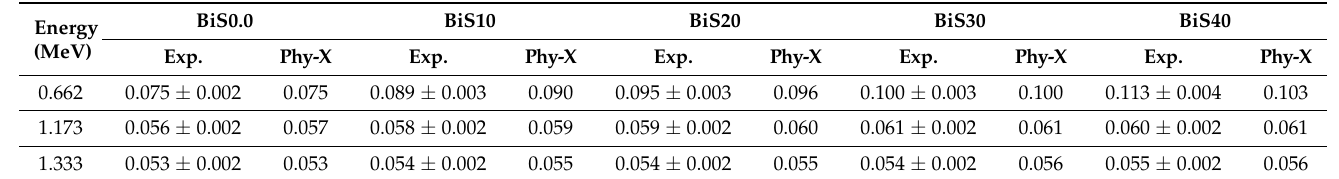
Table 2. MACs from experimental measurement and Phy-X/PSD software